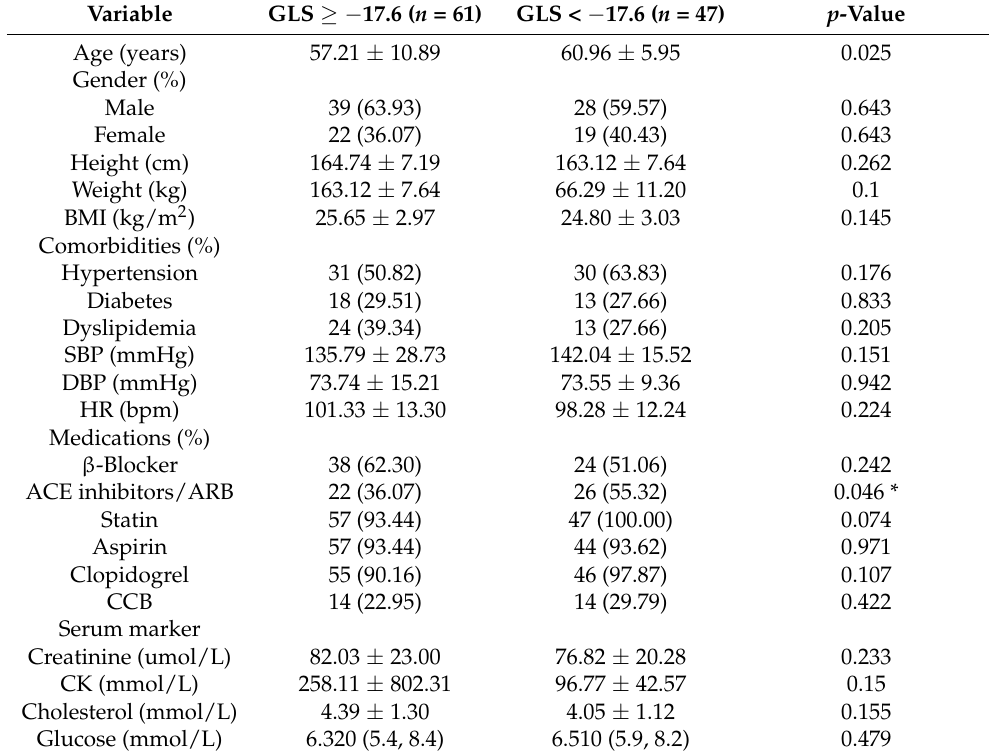
Table 1. Baseline characteristics stratified by a GLS median of −